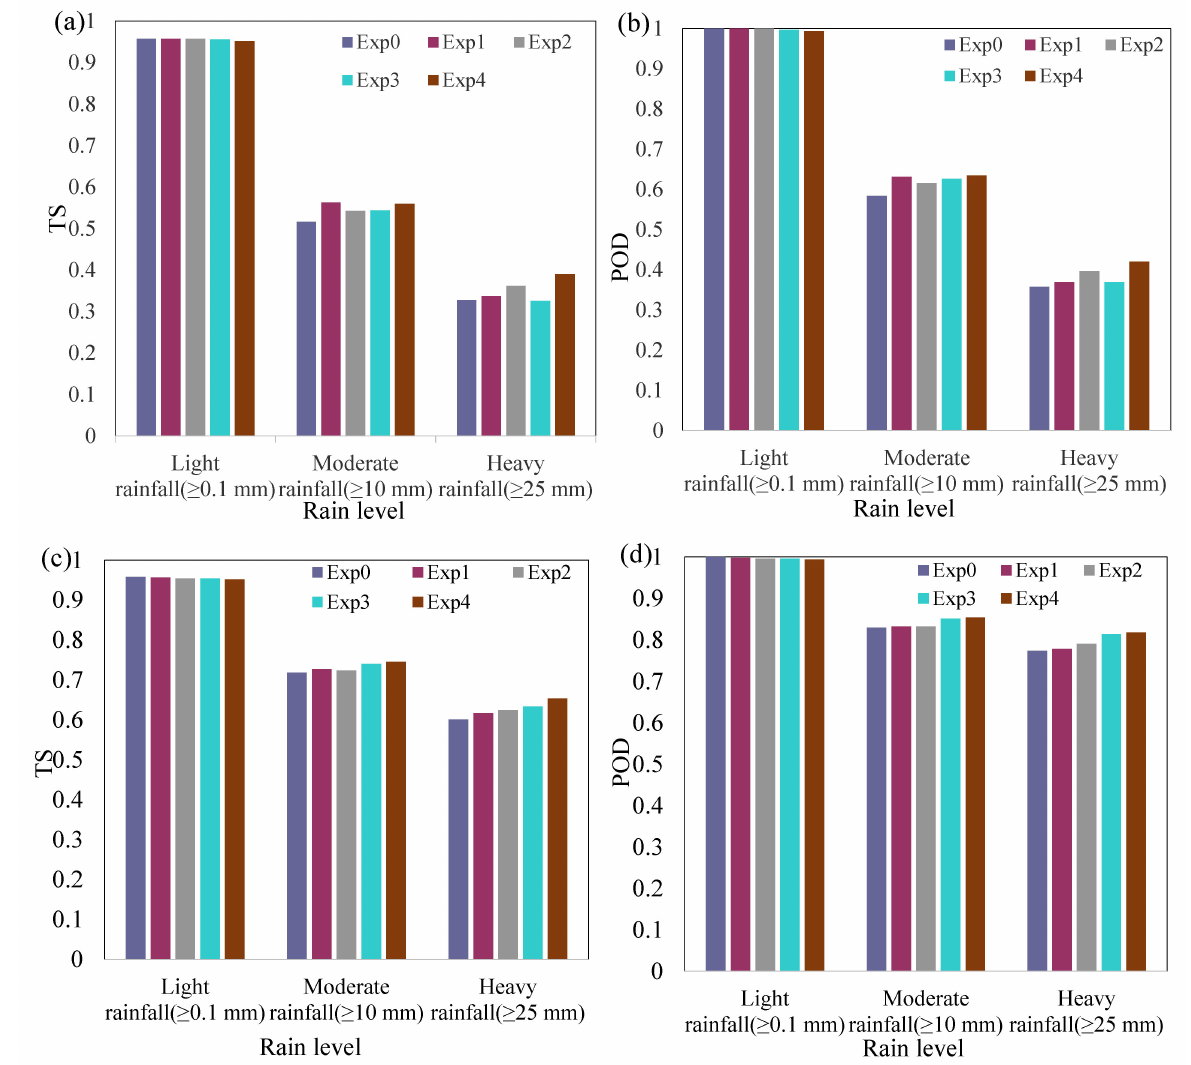
Figure 10. Evaluation indexes of the 24 h cumulative rainfall from 00:00 to 23:00 on 19 July. ( a , b ) are the results of the model started at 00:00 on 18 July, ( c , d ) are the results of the model started at 00:00 on 19 July, ( a , c ) show the TS values, ( b , d ) show the POD